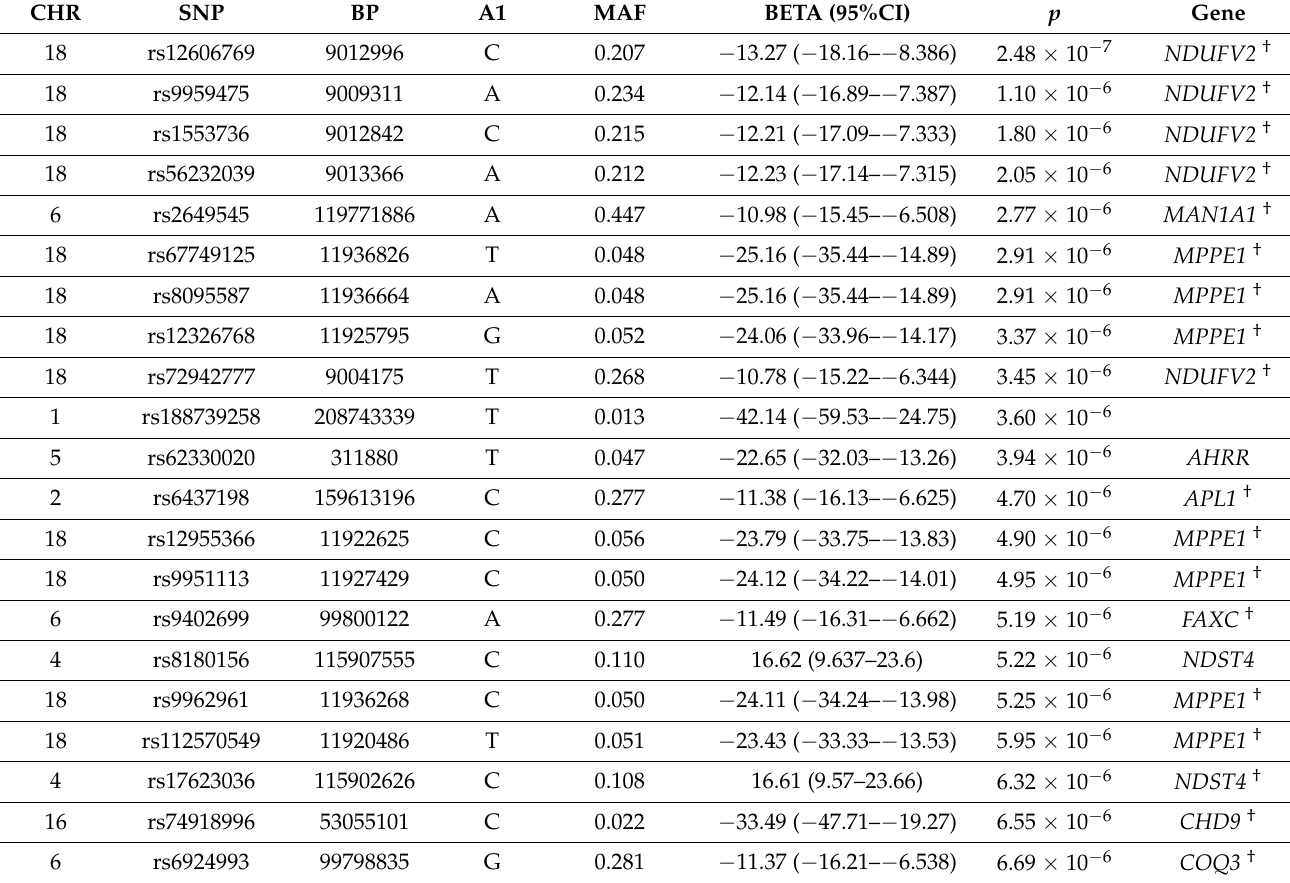
Figure 1. Manhattan plot of the GWAS on the percentage of LS changes at SVR. Horizontal lines correspond to of 1 × 10 − 5 and 5 × 10 − 8 p -values, respectively. Table 2. Best single-locus genetic association analysis results ( p < 10 − 5 ) obtained by plink.